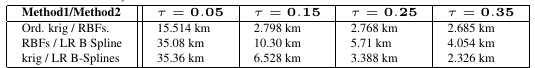
Table 5: Table of results for the averaged geographical distance (measured in km) between sets of local maxima (Liguria area size: 5.410 km 2 ). Method1/Method2 τ = 0 . 05 τ = 0 . 15 τ = 0 . 25 τ = 0 . 35 Ord. krig/RBFs.